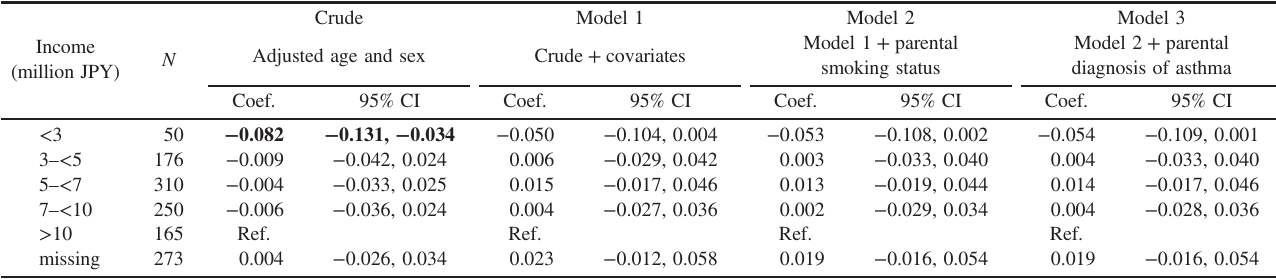
Table 2. The coe ffi cients of income on FEV1 / FEV6 by multiple regression analysis ( n = 1,224) Income (million JPY)